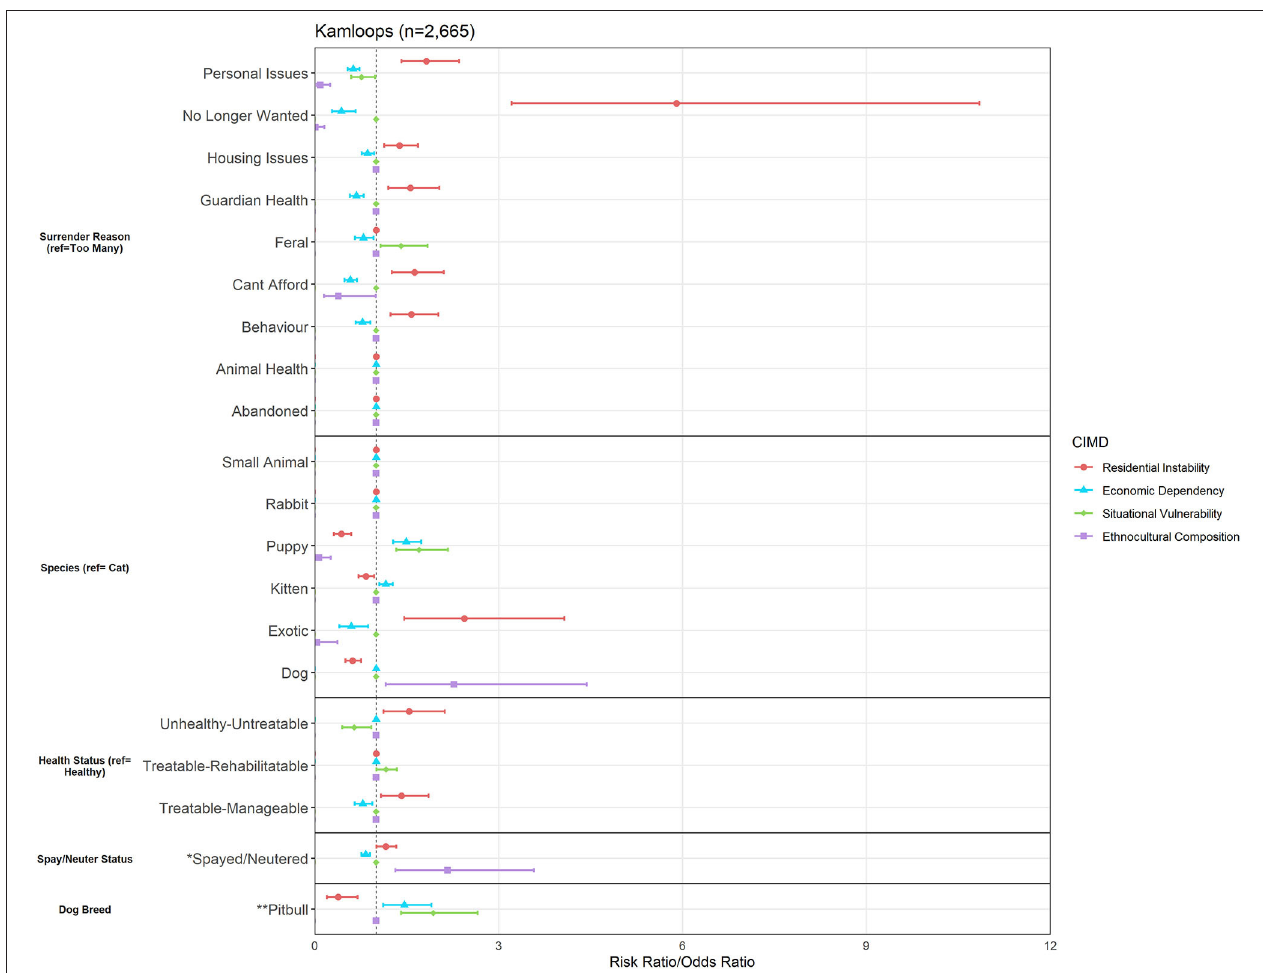
FIGURE 6 | Association between Canadian Index of Multiple Deprivation (CIMD) factors and owner surrender variables across the city of Kamloops and surrounding area ( n = 2,665). Results of logistic regression models for shelter variables by increasing CIMD factors are shown. Data are presented by risk ratios and their 95% confidence interval (bars); p < 0.05 when 95% confidence interval does not cross the vertical dotted line. Non-significant results are represented by a risk ratio of 1 with no CI. A risk ratio > 1 suggests an increased risk of that shelter variable category as you increase in deprivation, while a risk ratio < 1 suggests a reduced risk. *denotes data from dogs, cats, kittens, and puppies only ( n = 2,548) and is represented in odds ratios (and 95% CI). **denotes data from dogs and puppies only ( n = 657) and is represented in odds ratios (and 95%